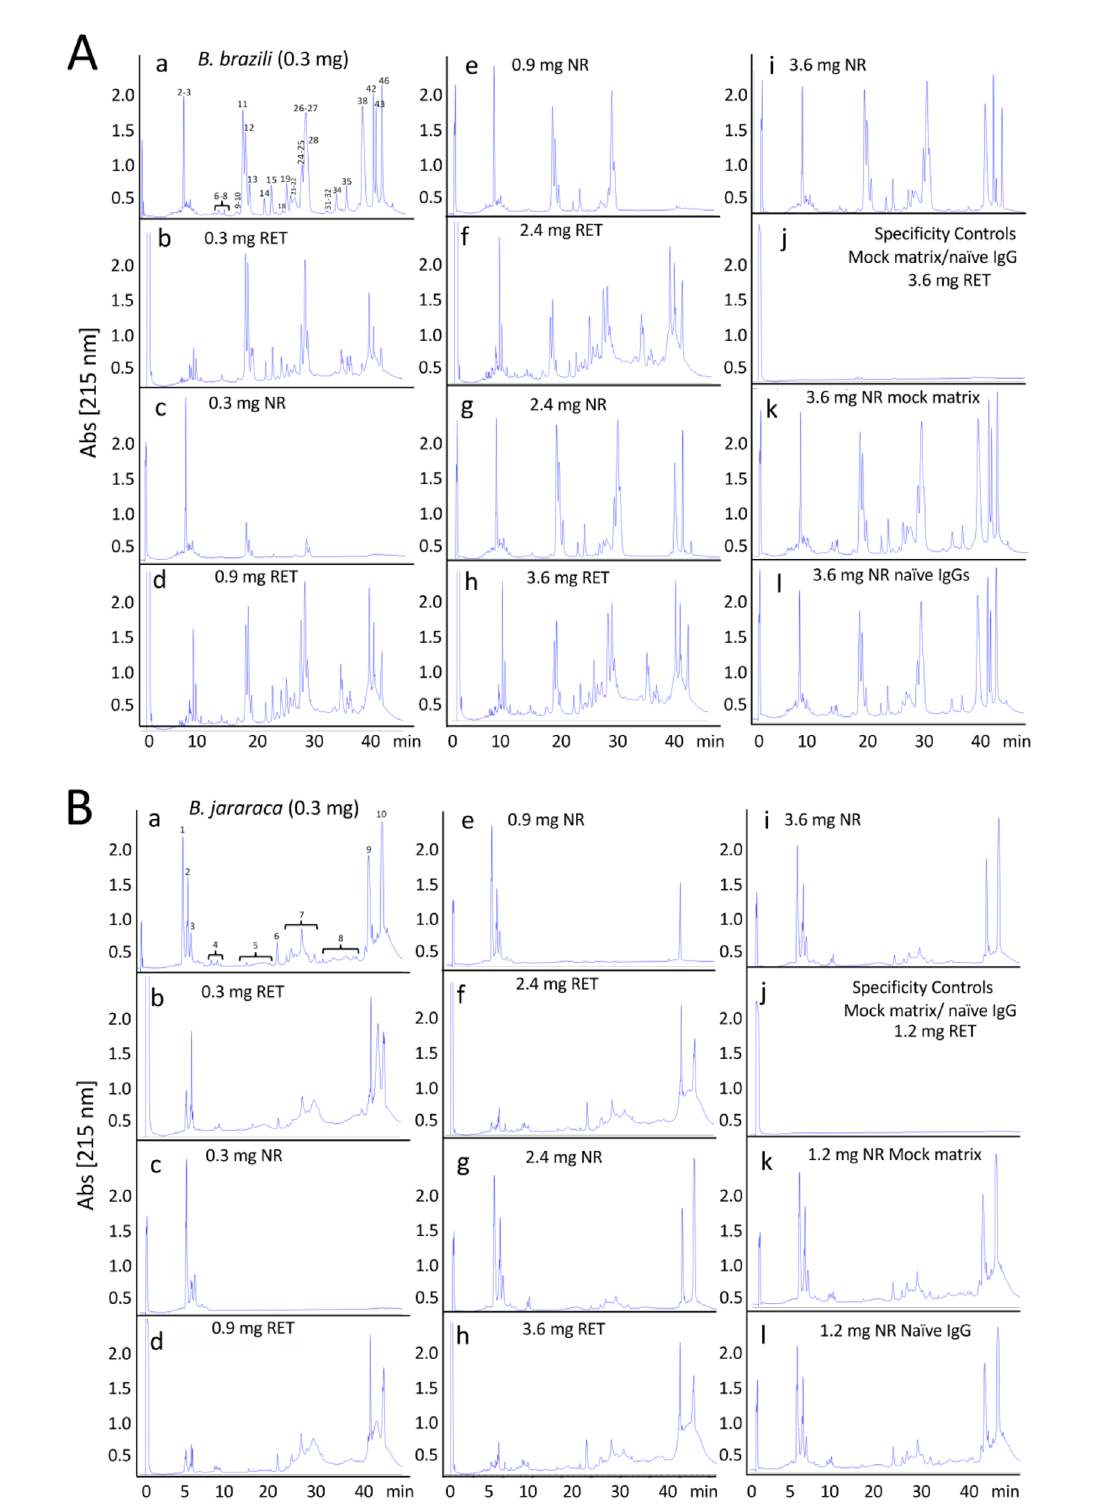
Figure 3. Comparative immunorecognition ability of the Brazilian SAB antivenom towards B. brazili and B. jararaca venom toxins. (A) Third-generation antivenomic analyses of B. brazili and (B) B. jararaca venom with the pentabothropic antivenom ( soro antibotrópico , SAB) produced at Butantan Institute. Reverse- phase chromatographic analysis of whole venom (panels a ) and of the non-retained and the immunoretained fractions recovered from affinity column [9 μg immobilized SAB antivenom F(ab’) molecules] incubated with increasing amounts (300-3600 μg) of venom from ( A ) B. brazili (Pará, Brazil) and ( B ) B. jararaca 2 (SE population) are displayed in panels b through i . Panels j-l show reverse-phase HPLC separations of the retained and non-retained venom fractions on mock matrix and naïve equine IgG affinity columns,